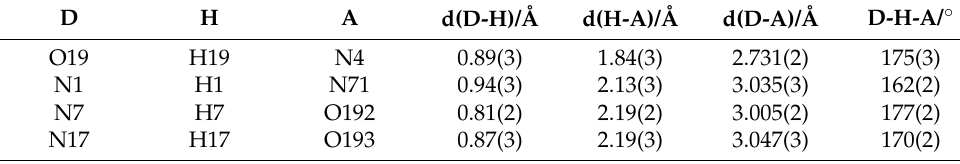
Table 1. Observed hydrogen bonding interactions in the title compound. D H